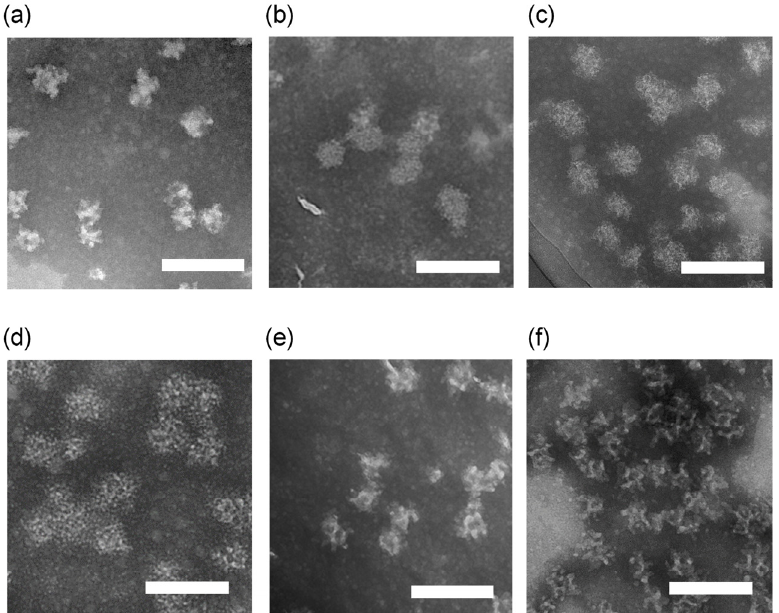
Figure 3. TEM images of BNP before and after the Suzuki–Miyaura cross-coupling reaction. ( a ) BNP (no modification), ( b ) NP-1, ( c ) NP-2, ( d ) NP-3, ( e ) NP- 4, and ( f ) NP-5. For NP-4 and NP-5, the Boc-protecting group was removed with HCl (aq) before acquiring the TEM images. Samples were negatively stained with 2 wt% sodium dodecatungstato(VI) phosphate solution. Scale bars: 200 nm.